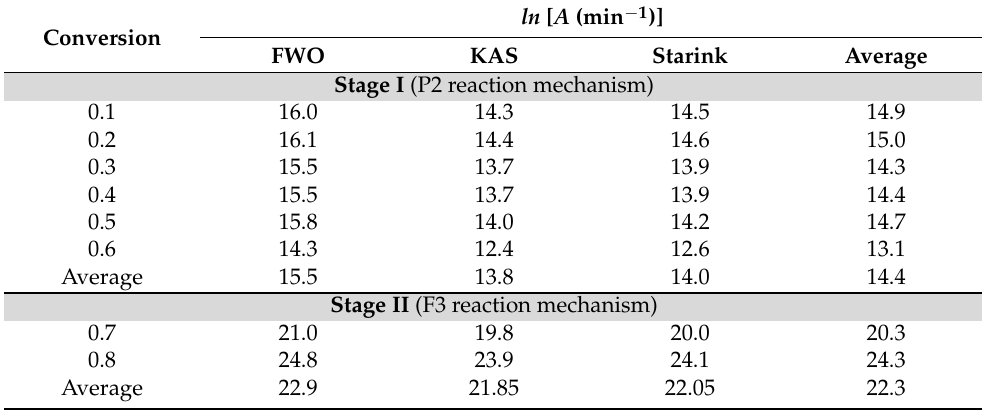
Table 8. Pre-exponential factor values obtained by isoconversional